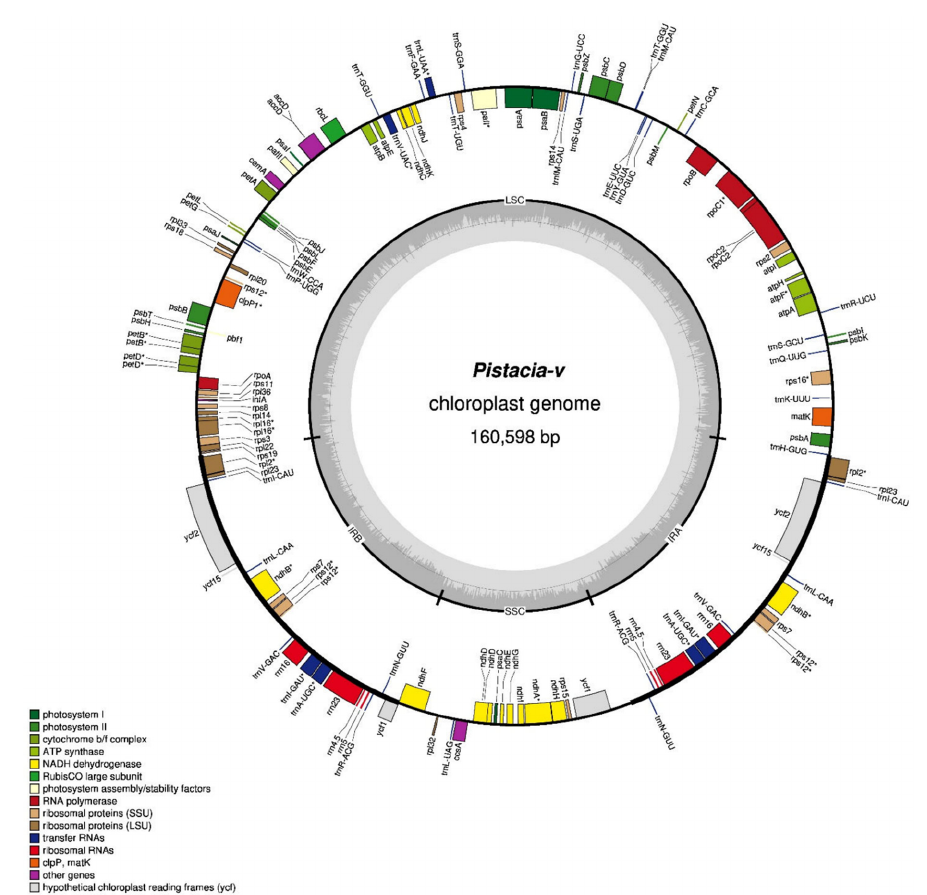
Figure 1. Chloroplast genome map of P. vera depicted with OGDRAW software. Genes identified inside the circle are transcribed clockwise and those drawn outside of the circle are transcribed counterclockwise. Genes having similar functions are shown in the same colors. The inner circle illustrates nucleotide compositions (light grey, AT content; dark grey, GC content). Itron containing genes are marked with ʹ * ʹ . Table 2. Functions of genes identified from the P. vera chloroplast genome.